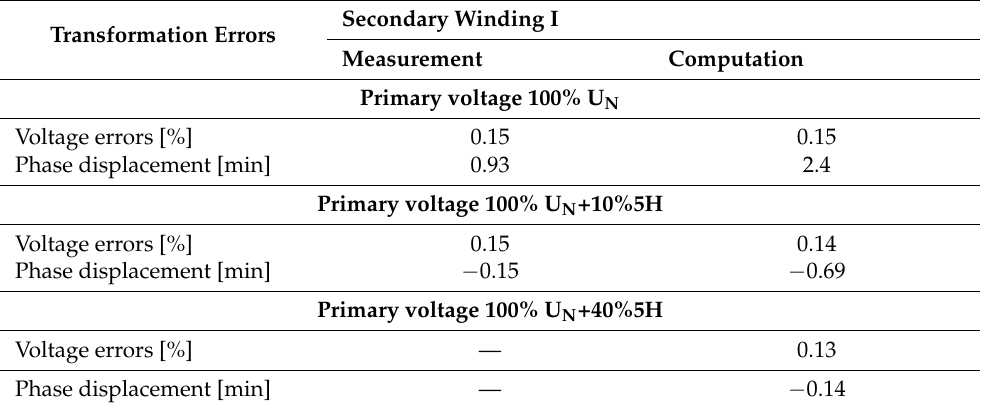
Table 3. Comparison of calculated and measured voltage errors of the tested VT at distorted voltage and load 2 M Ω